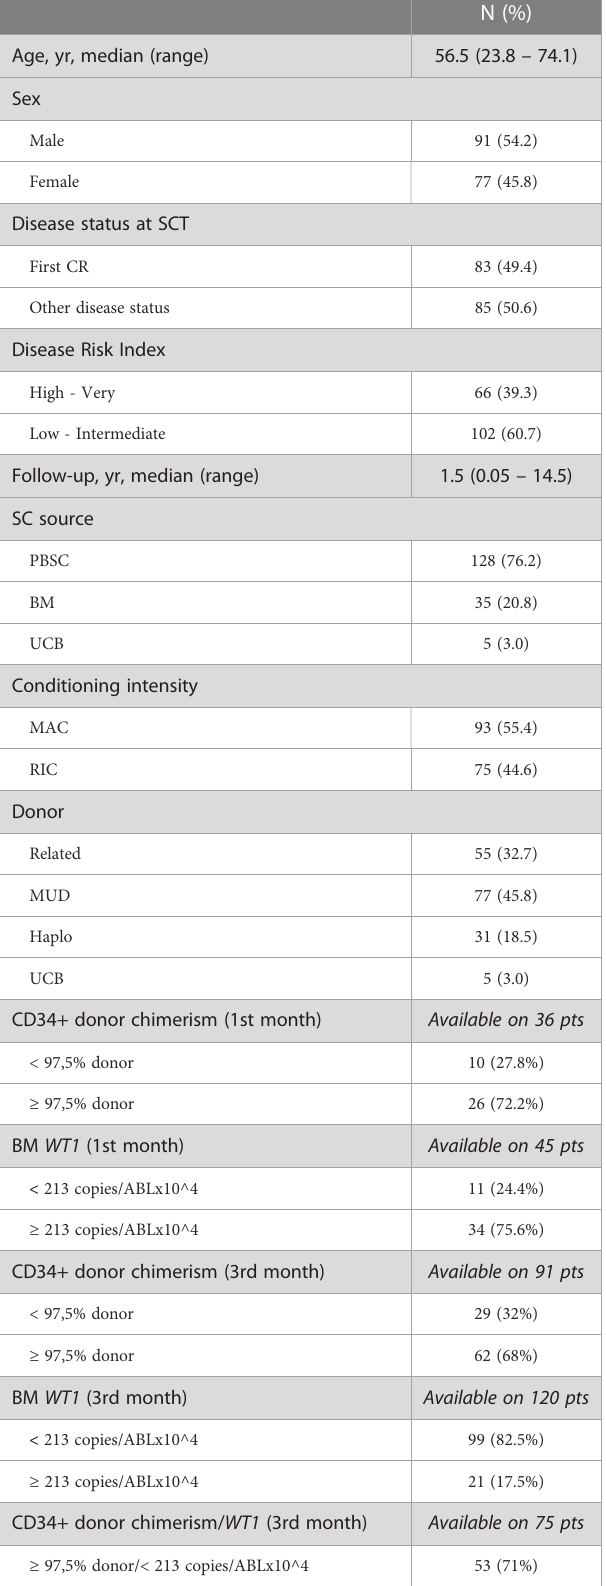
TABLE 1 Clinical and transplant characteristics of 168 AML patients included in this